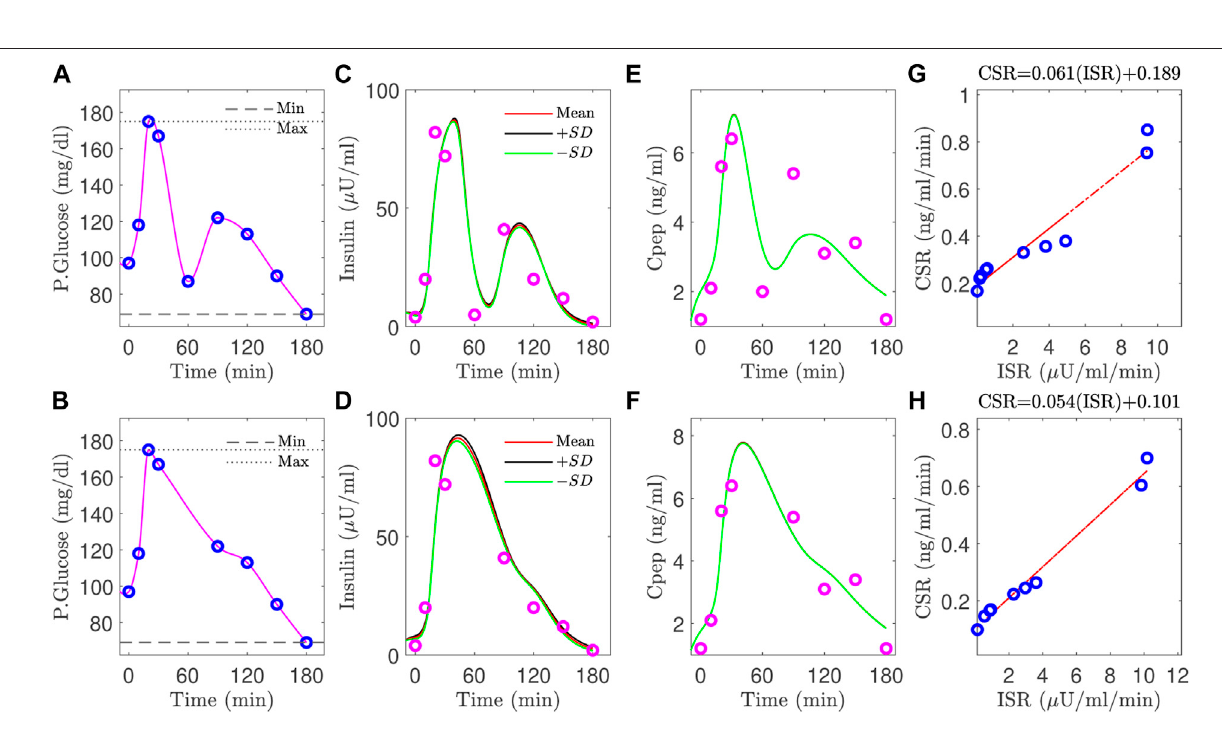
Frontiers in Physiology |